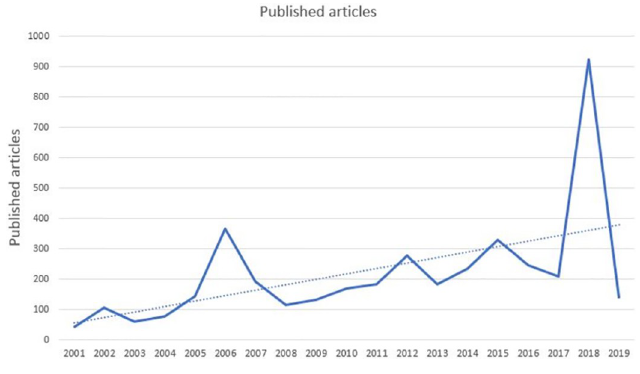
Fig 3. The number of news articles about SCO in